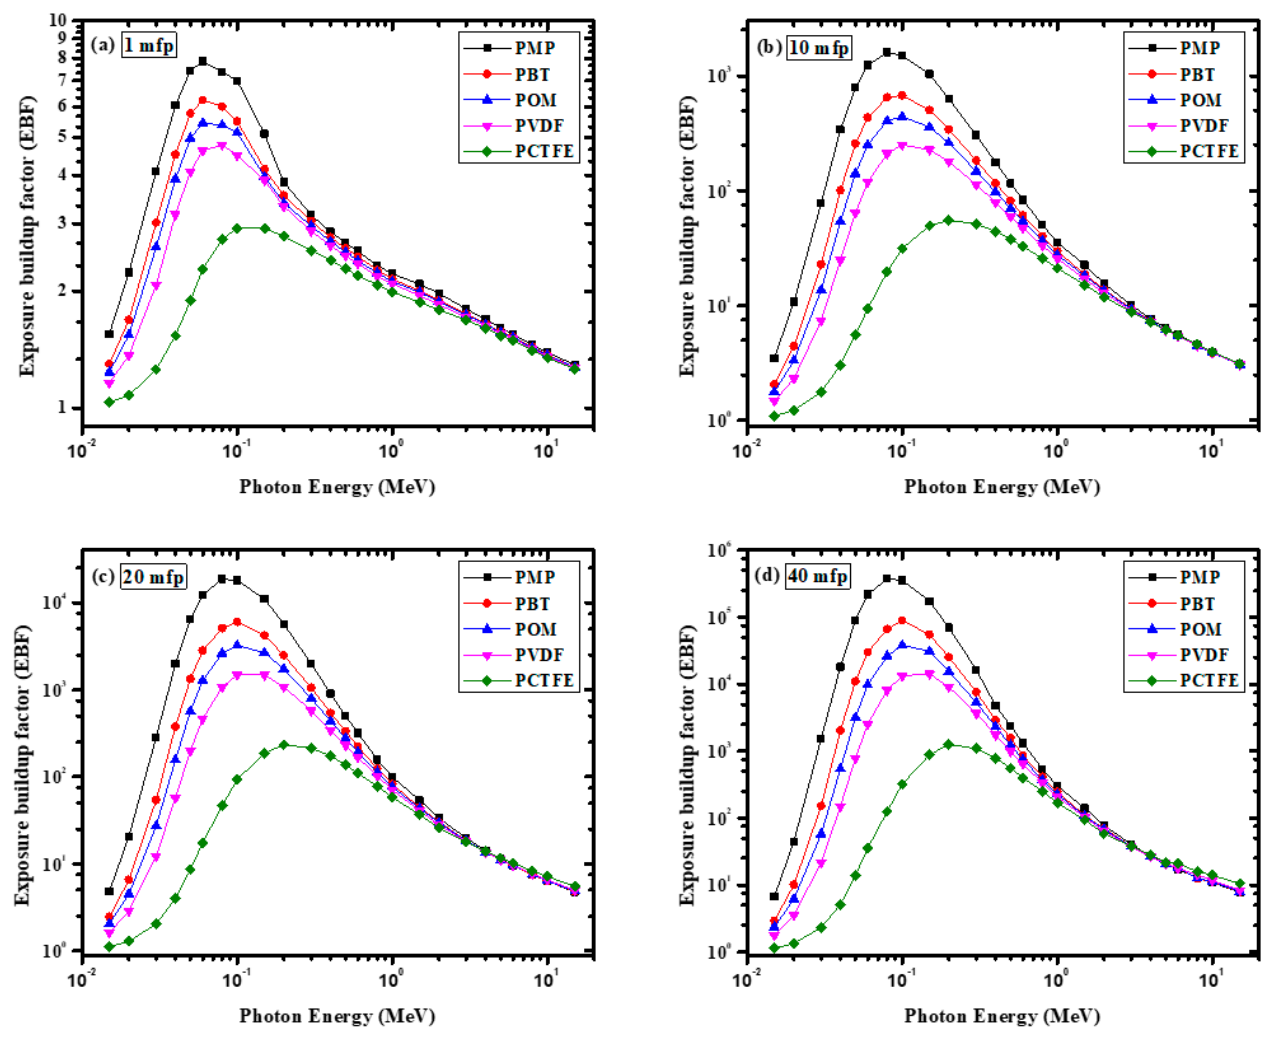
Figure 10. The variation of EBF with γ-ray energy for the investigated polymers at ( a ) 1 mfp, ( b ) 10 mfp, ( c ) 20 mfp, and ( d ) 40 mfp.